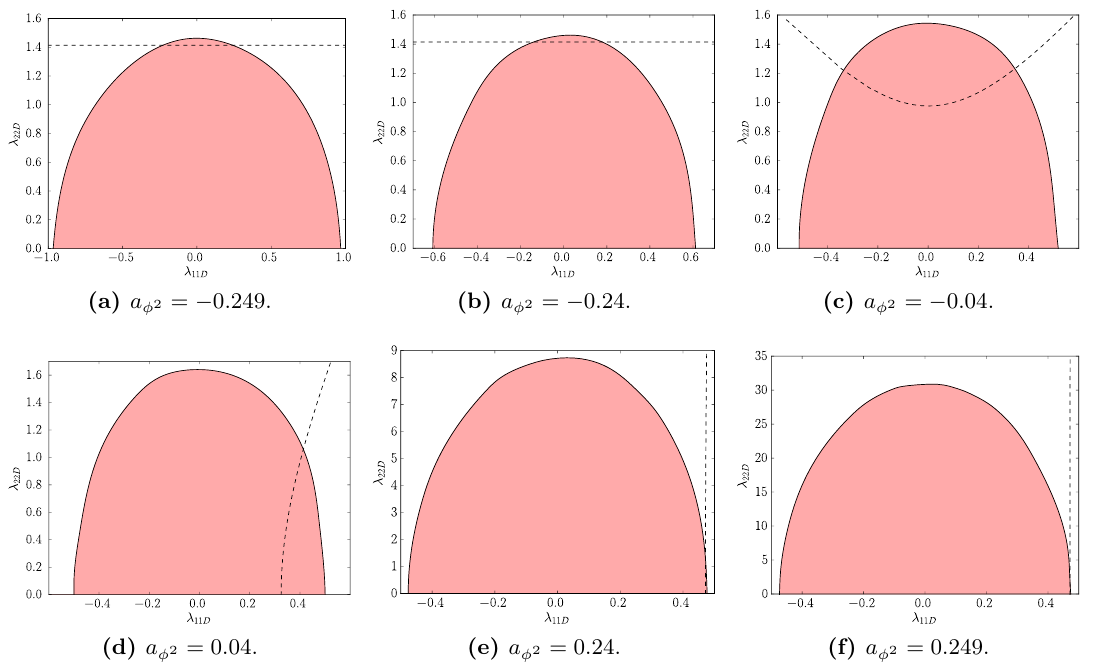
√ C D . When this line